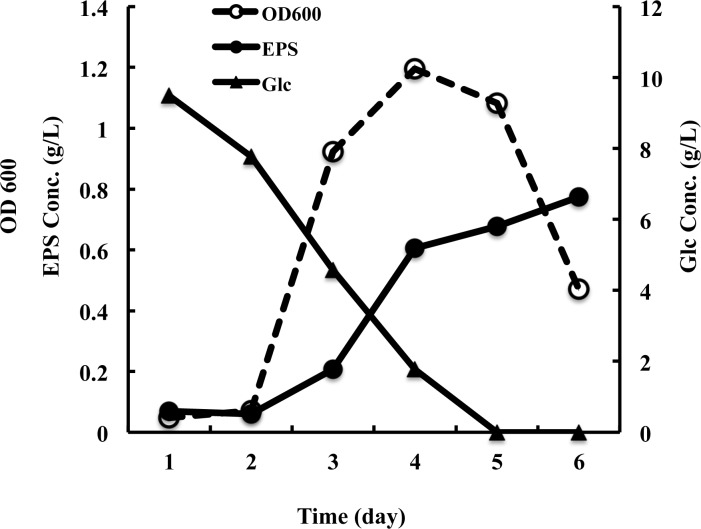
EPS production by JL2810.Time course of bacterial growth (OD600), EPS production, and Glc consumption during the cultivation of JL2810.